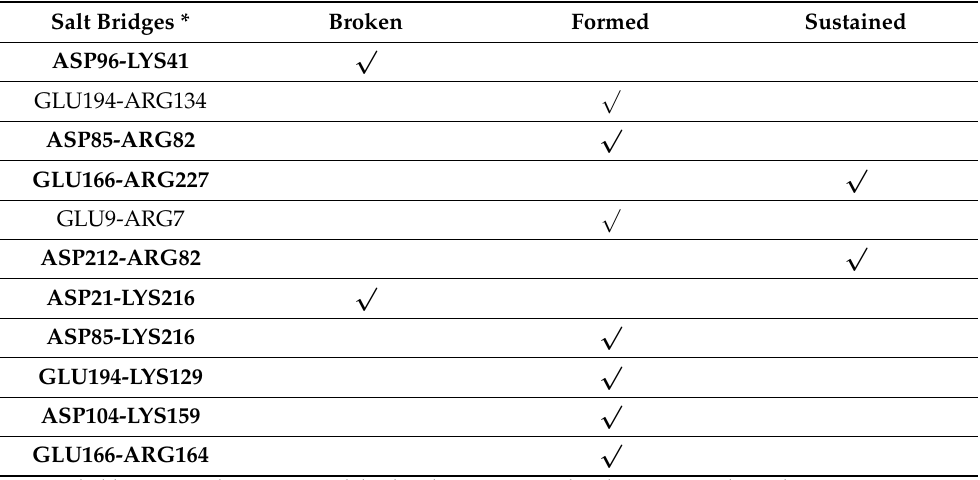
Table 1. Salt bridges within bR in the absence of graphene (the typical distance of 3.2 Å between Oxygen and Nitrogen atoms is considered as a criterion to determine the status of the salt bridges where distances less than 3.2 Å reflect formed salt bridges, greater than 3.2 Å reflect broken salt bridges and if the distances were lesser than 3.2 Å all throughout the simulation, it reflects the ‘Sustained’ category).